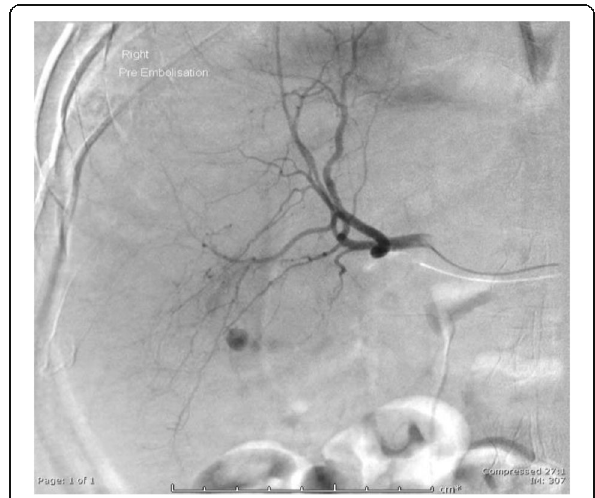
Fig. 4 Hepatic artery angiogram demonstrating cystic artery pesudoaneurysm